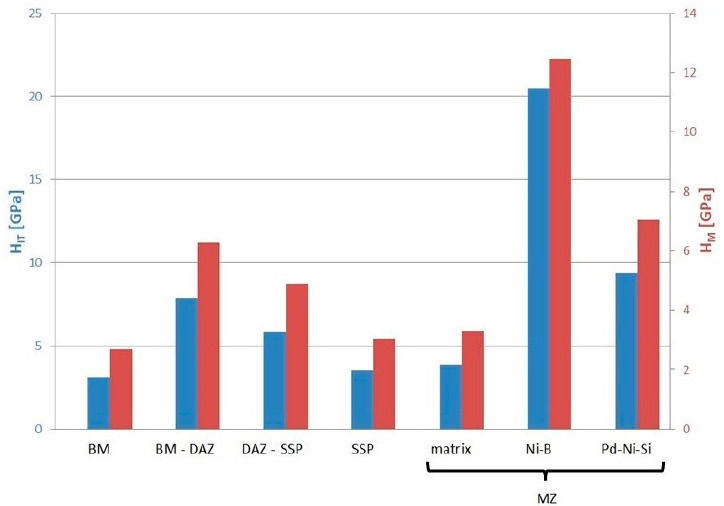
Figure 12. Indentation hardness and Martens hardness for structure elements of Hastelloy X–Palnicro 36M brazed joint.